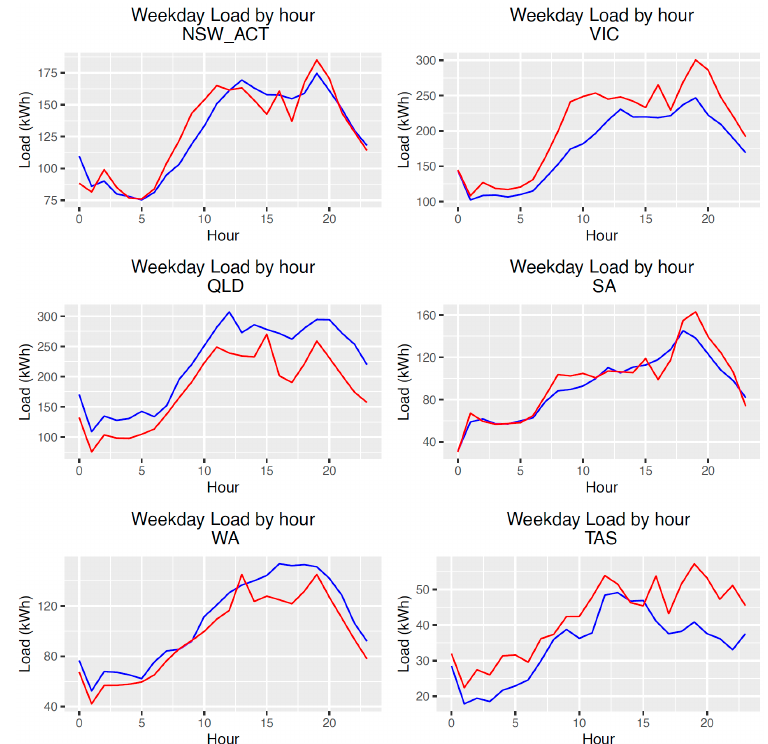
Figure 2. Hourly consumption weekday totals presented as line graphs for all households by state. Blue: pre-lockdown, Red: lockdown. X axis: time of day, Y axis: cumulative load of all monitored households for each preceding hour (e.g., 10 am = energy used between 9–10 am).